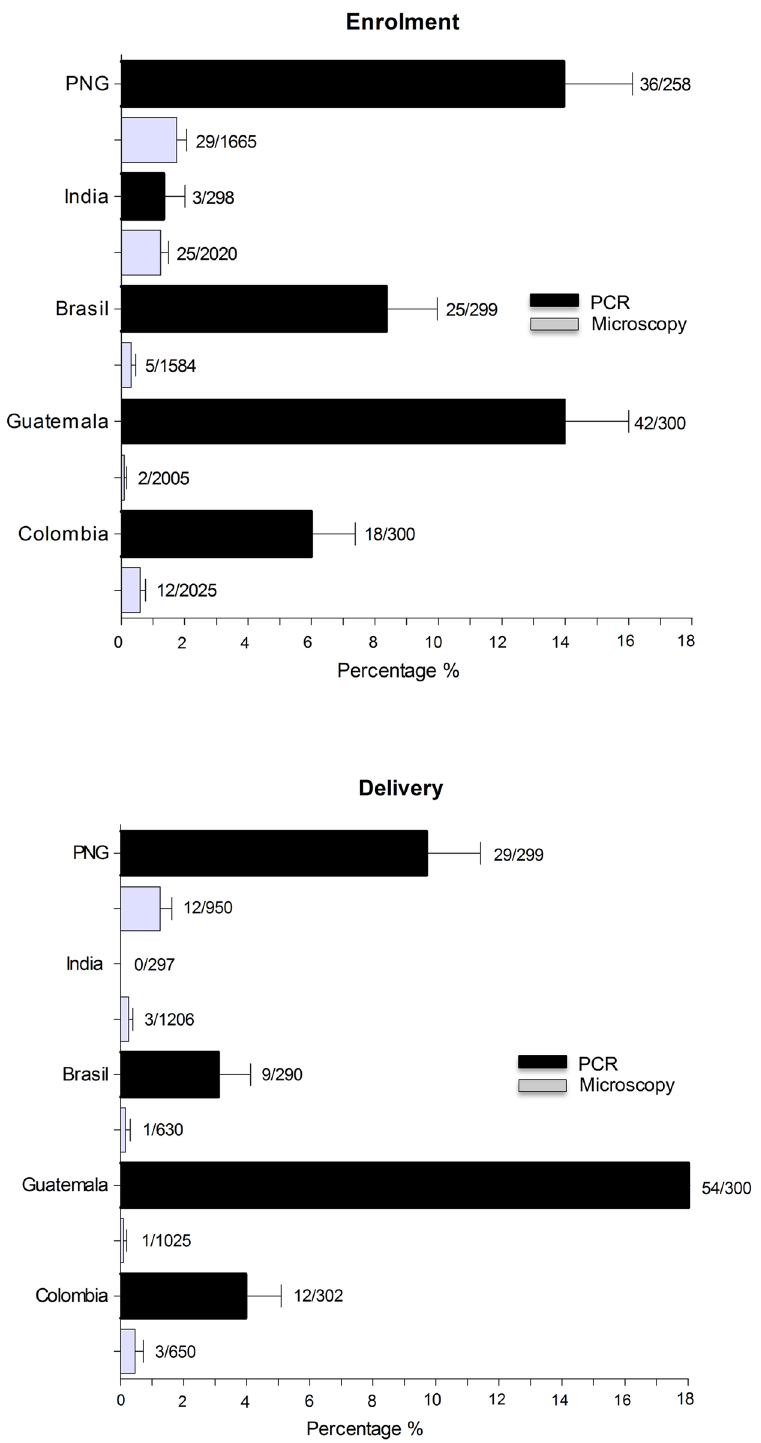
Fig 2. Prevalence of P . vivax